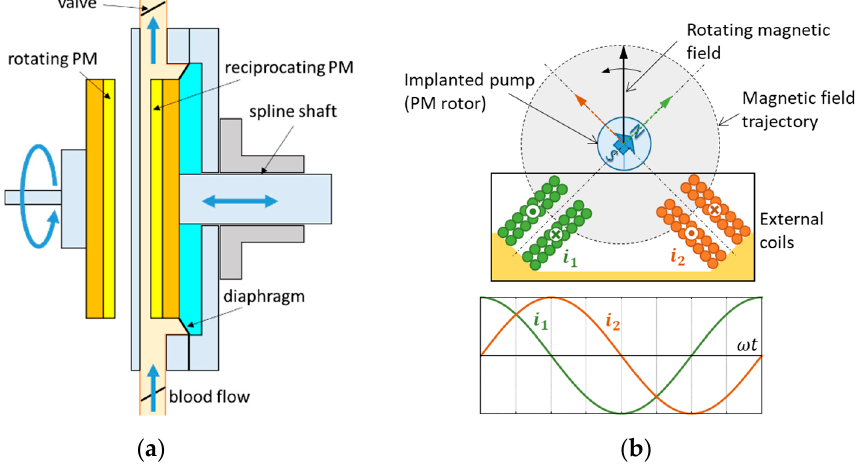
Figure 12. Configurations for the contactless mechanical power transfer; ( a ) external rotating PM disk coupled with an implanted reciprocating PM disk; and ( b ) external 2-phase coils supplied by 90° shifted sinusoidal currents interacting with a 2-pole PM rotor.